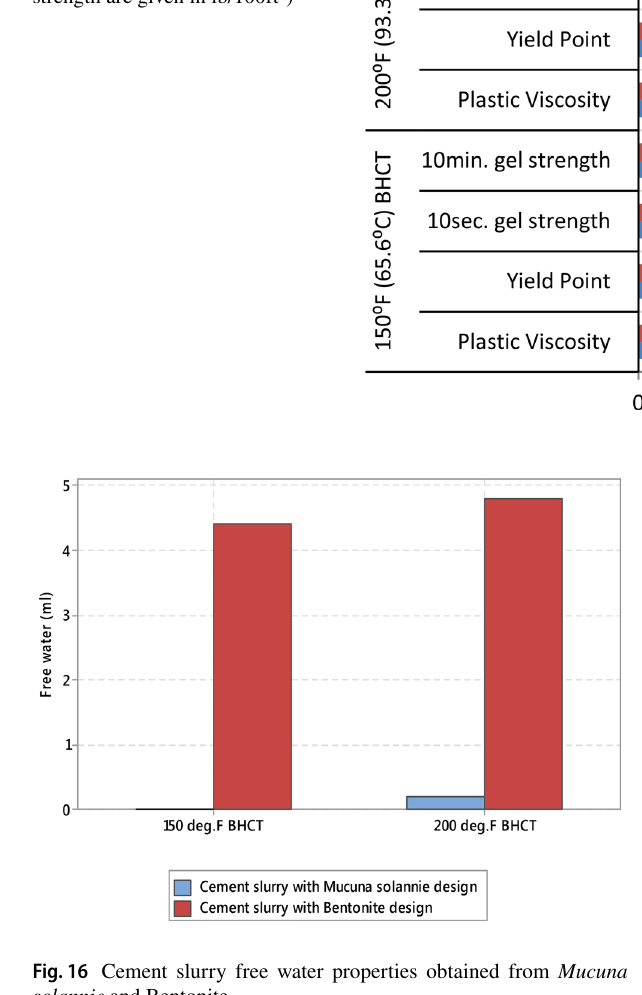
Fig. 15 Cement slurry rheo- logical properties obtained from Mucuna solannie and Bentonite (where the yield point and gel strength are given in lb/100ft 2 )